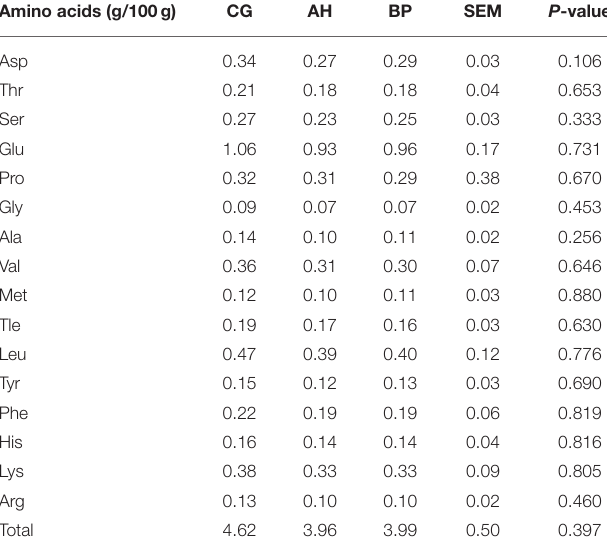
TABLE 7 | Fatty acids composition in the milk.